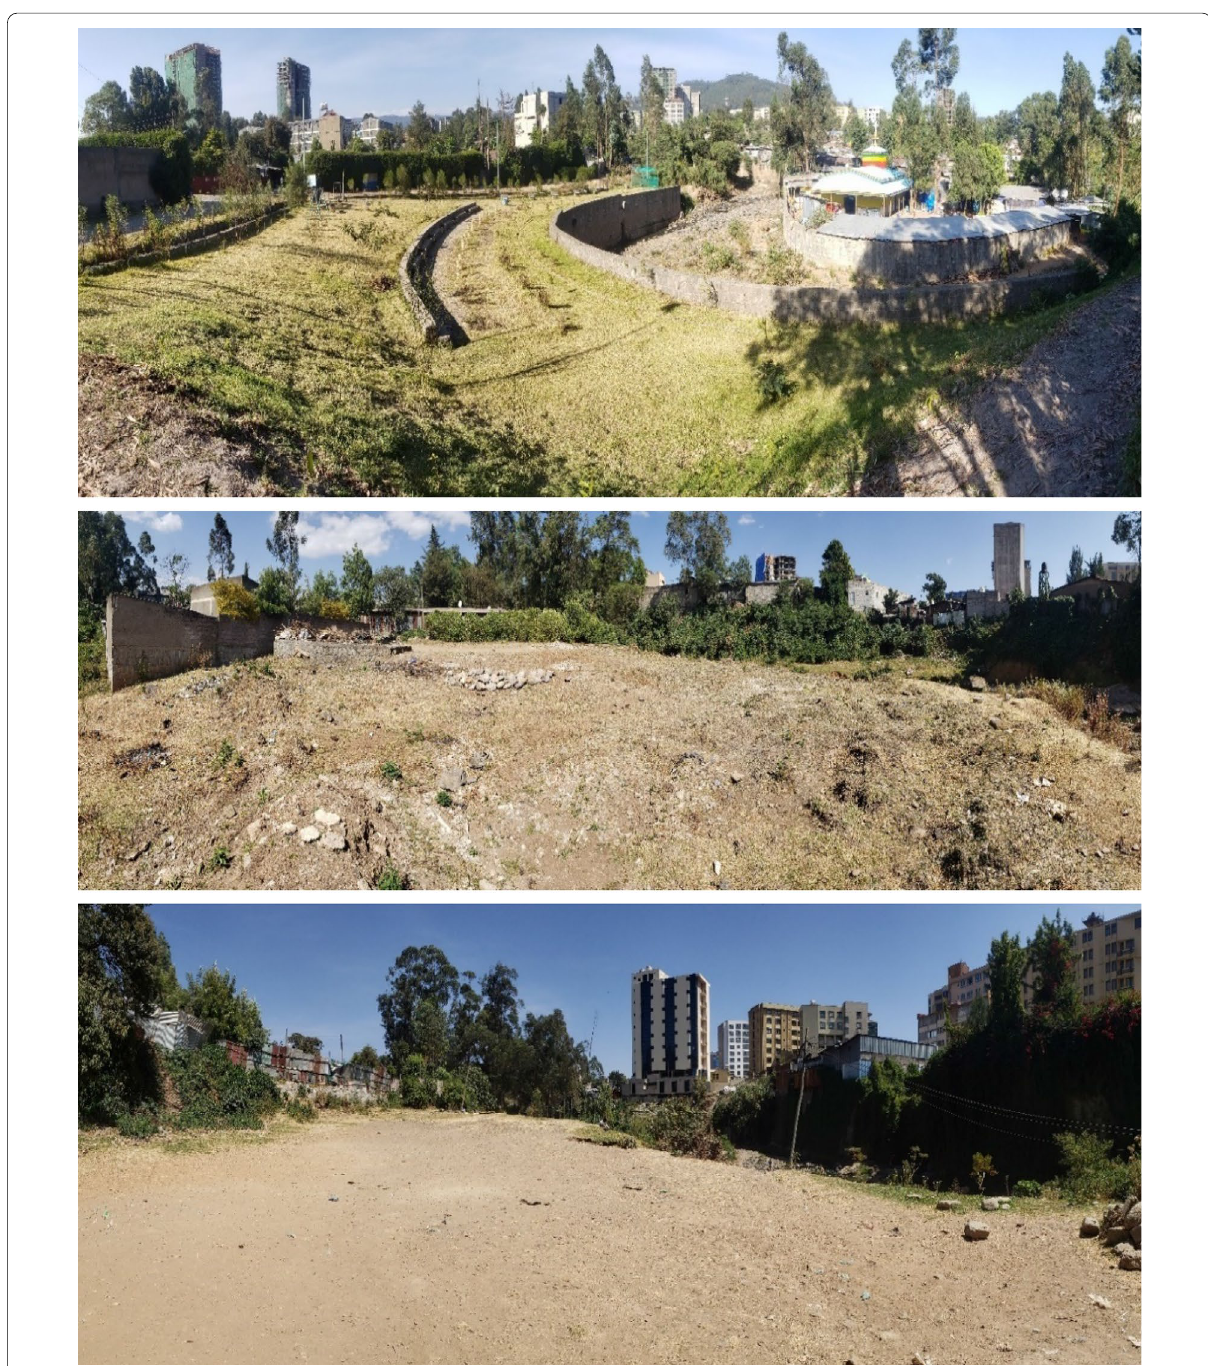
Fig. 2 Photographs showing some segments of the three selected sites ( Top- Wisdom Park, Middle—Minister Meda, and Bottom -Agoza Meda